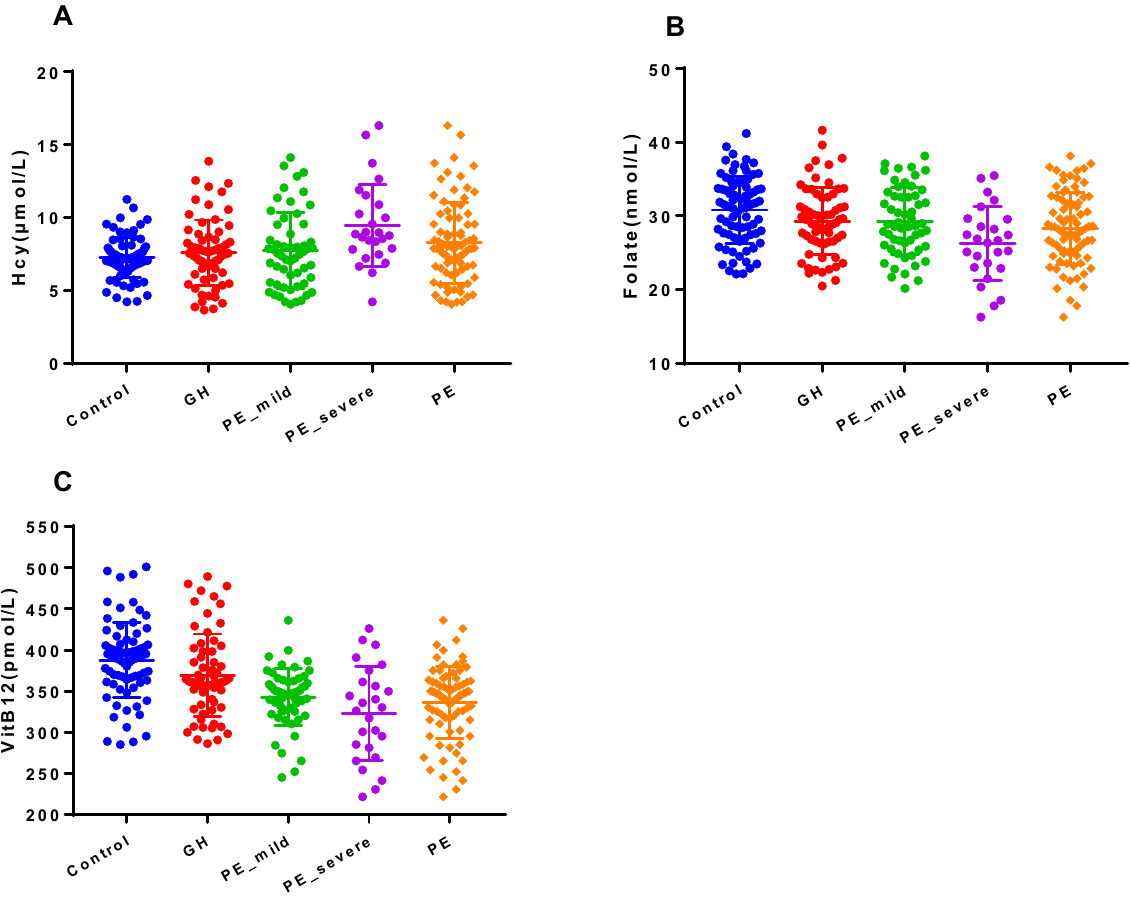
Figure 1: Scatter plot of serum Hcy, folate and ViB12 level (A: serum Hcy distribution; B: serum folate distribution; C: serum ViB12